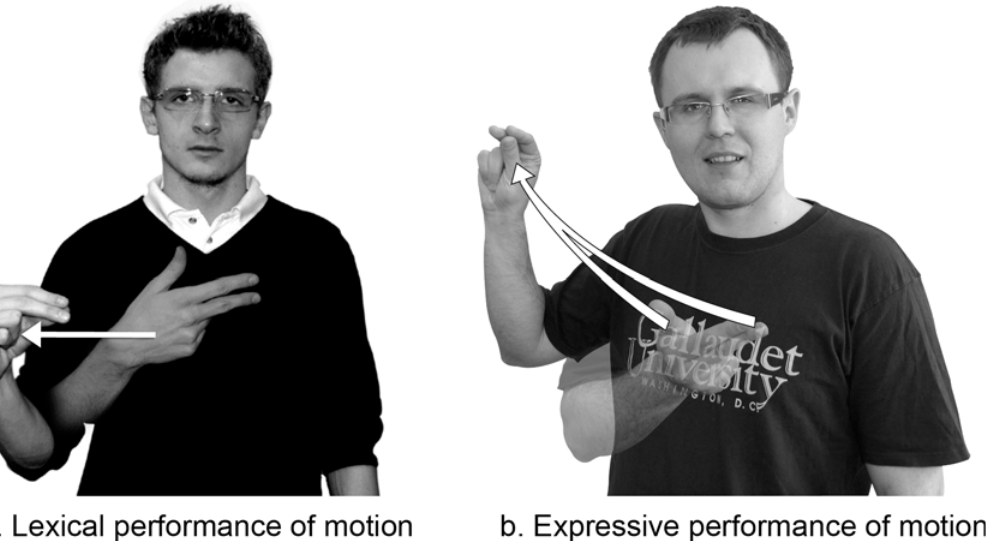
Fig 2. Two ways of articulating the fingerspelled loan sign #NIE: lexically or expressively. The two individuals in this figure have given written informed consent (as outlined in PLOS consent form) to publish these case